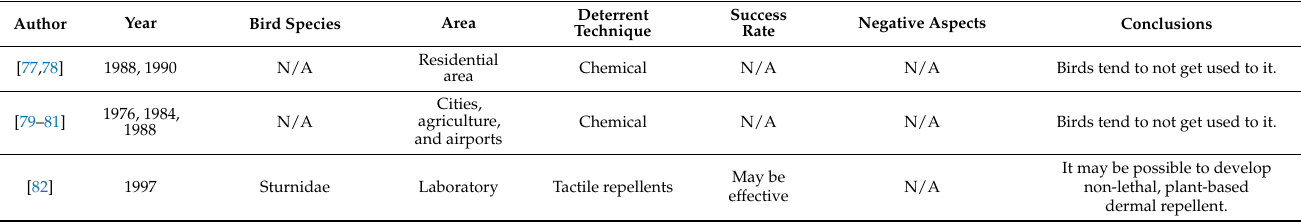
Table 3. Summary of the studies using chemical